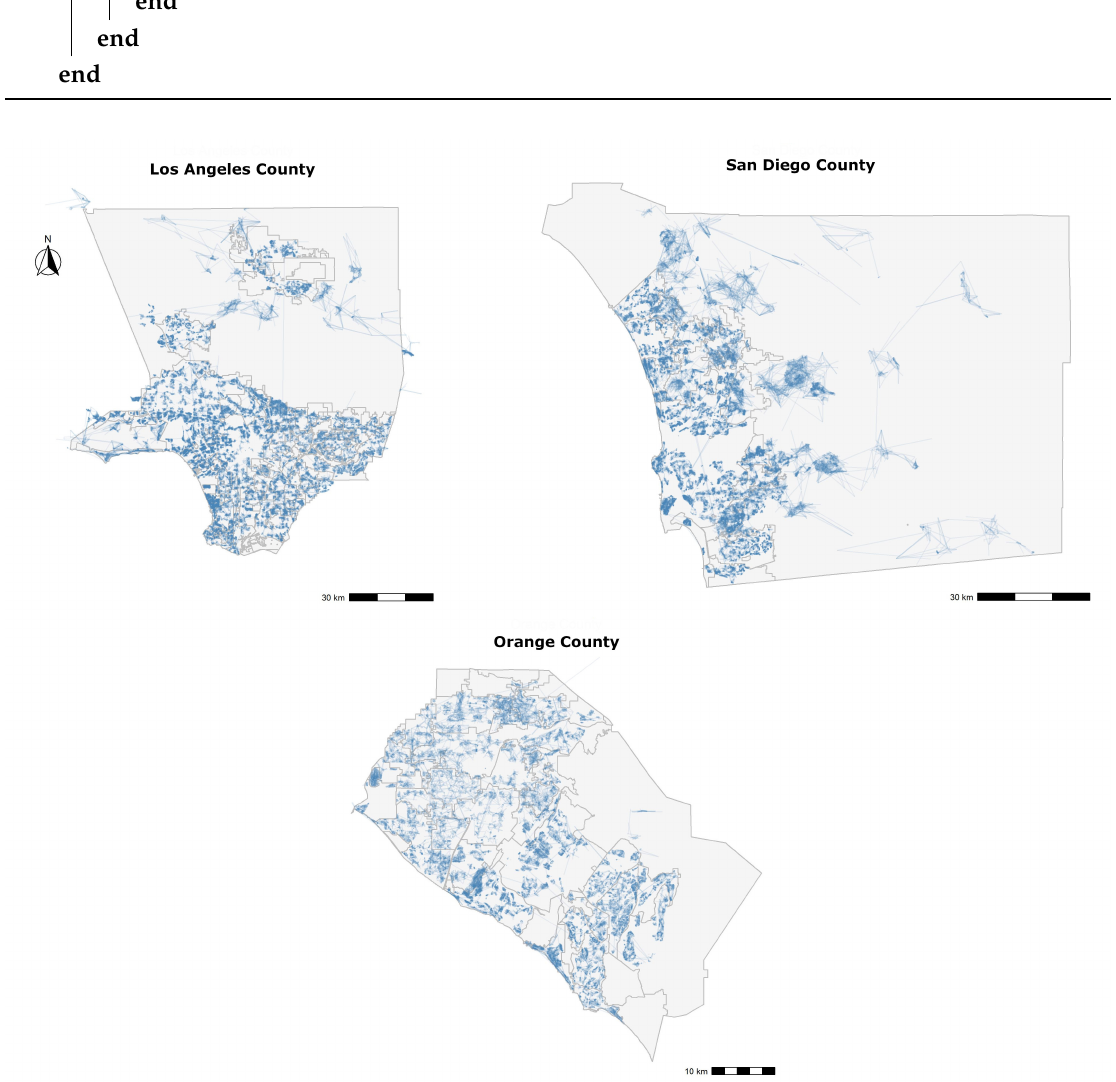
Figure 7. Post filtration network map between subjects and comparable